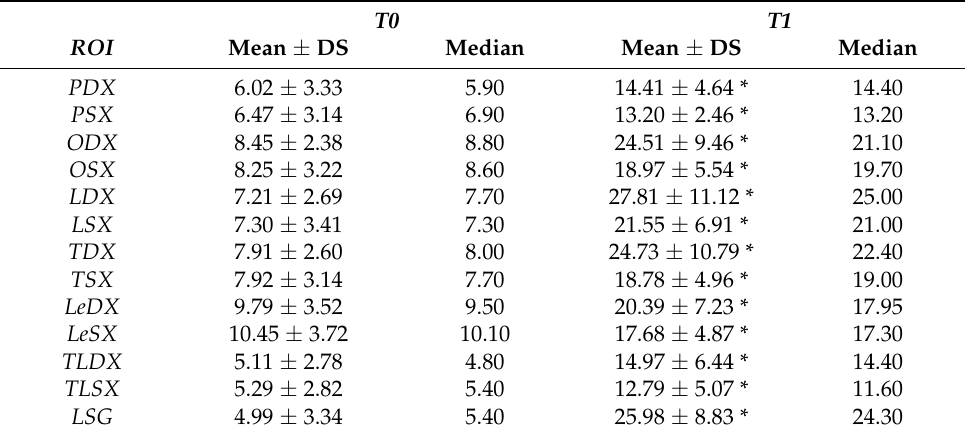
view of the right thigh region; TSX, lateral view of the left thigh region; LeDX, lateral-caudal view of the right leg region; LeSX, lateral-caudal view of the left leg region; TLDX, caudal view of the thigh and right leg region; TLSX, caudal view of the region of the thigh and left leg; LSG, caudal view of the lumbar region, sacral region and dorsal portion of the hip or gluteal region). All values in T1 resulted statistically significant increased compared to T0